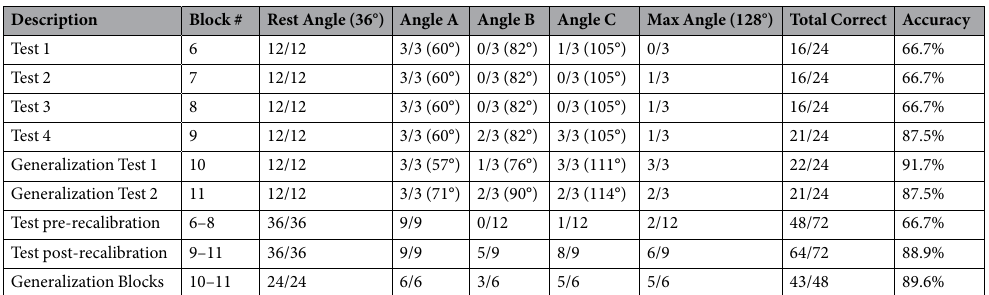
Table 2. Summary of Participant Accuracy Over Test Blocks. Stimulation parameters were recalibrated between the third and fourth test block. Angles A, B, and C were at 60°, 82°, and 105° respectively for blocks 6–9 and were moved to angles not previously attempted—57°,76°, and 111° for the first generalization test block (Block 10) and 71°, 90°, and 114° for the second generalization test block (Block